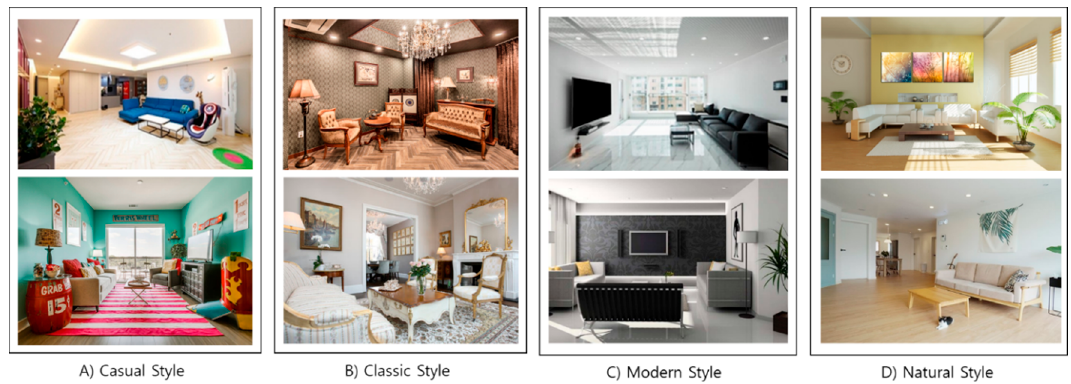
Figure 3. Examples of collected interior design images that were classified according to design style.